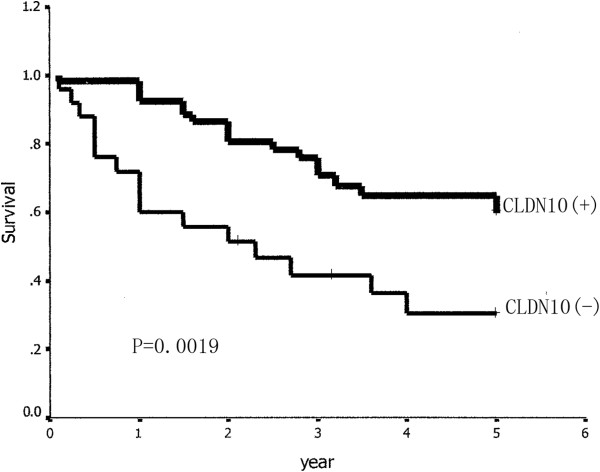
Relationship between expression of CLDN10 and survival of patients with lung adenocarcioma. Patients with positive CLDN10 expression had a better survival than those with negative expression (P = 0.0019).